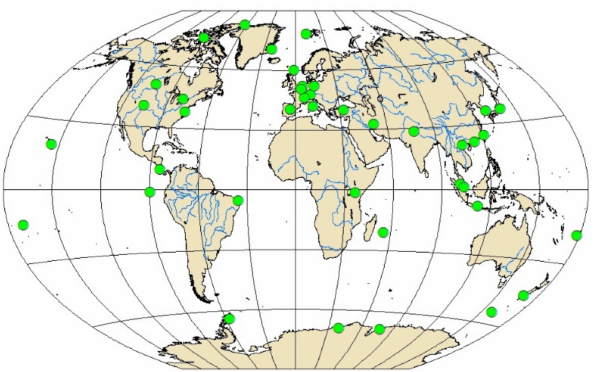
Figure 1. Locations of the worldwide ozonesonde launch stations of the World Ozone and Ultraviolet Data Center (WOUDC) (medium green dots) from 2014 to 2020.